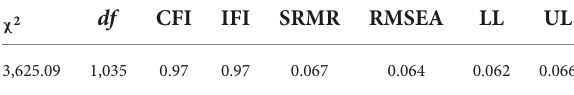
TABLE 1 Fit indices for the measurement